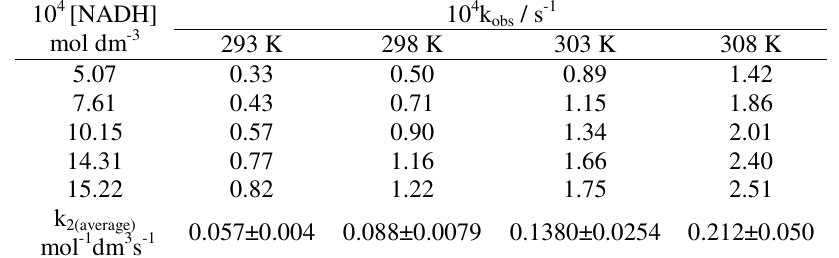
= 9.93 × 10 -5 mol dm -3 and pH = 7.5 T